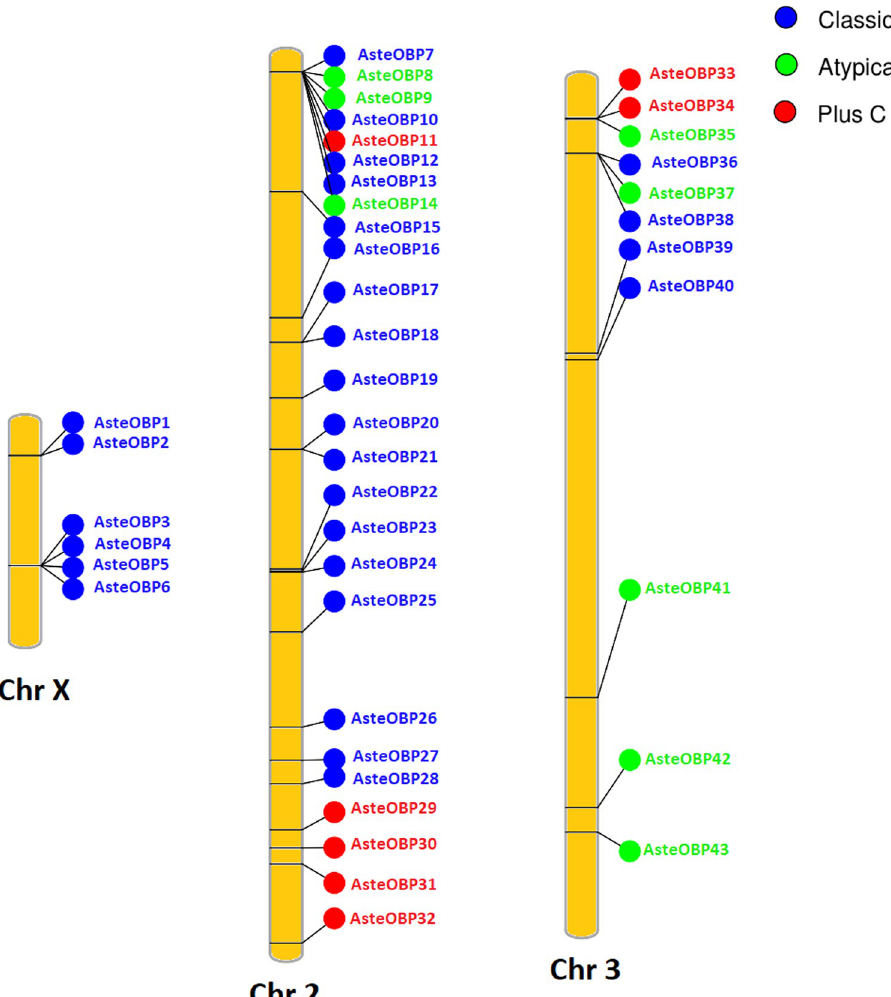
Fig 2. Chromosomal location of Odorant Binding Proteins (OBPs). Aste OBPs are shown based on their position on chromosomes of the An . stephensi . Chromosome 2 contained highest number of OBP genes. Some OBPs are clustered on the